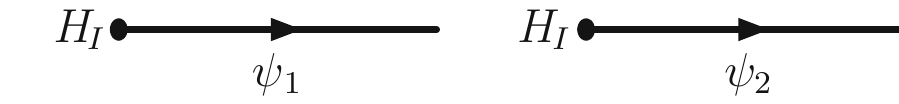
Fig. 1 The amplitudes A 1 and A 2 correspond to a neutrino which is created from the ground state of the free Hamiltonian H 0